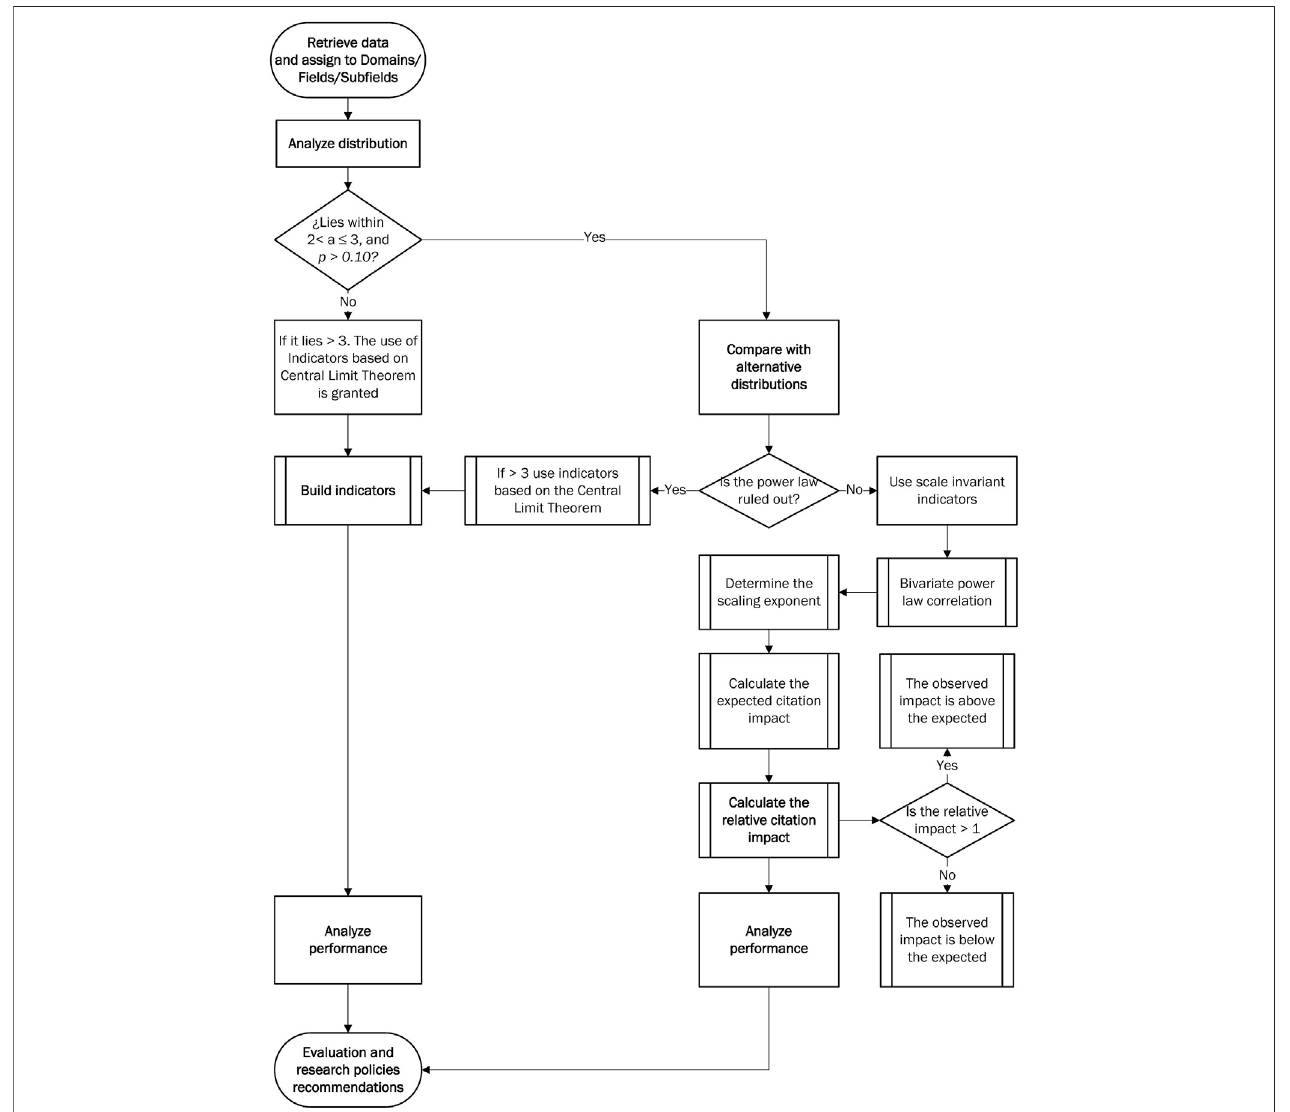
FIGURE 1 | Flowchart of the framework to assess the citation performance of complex innovation systems.